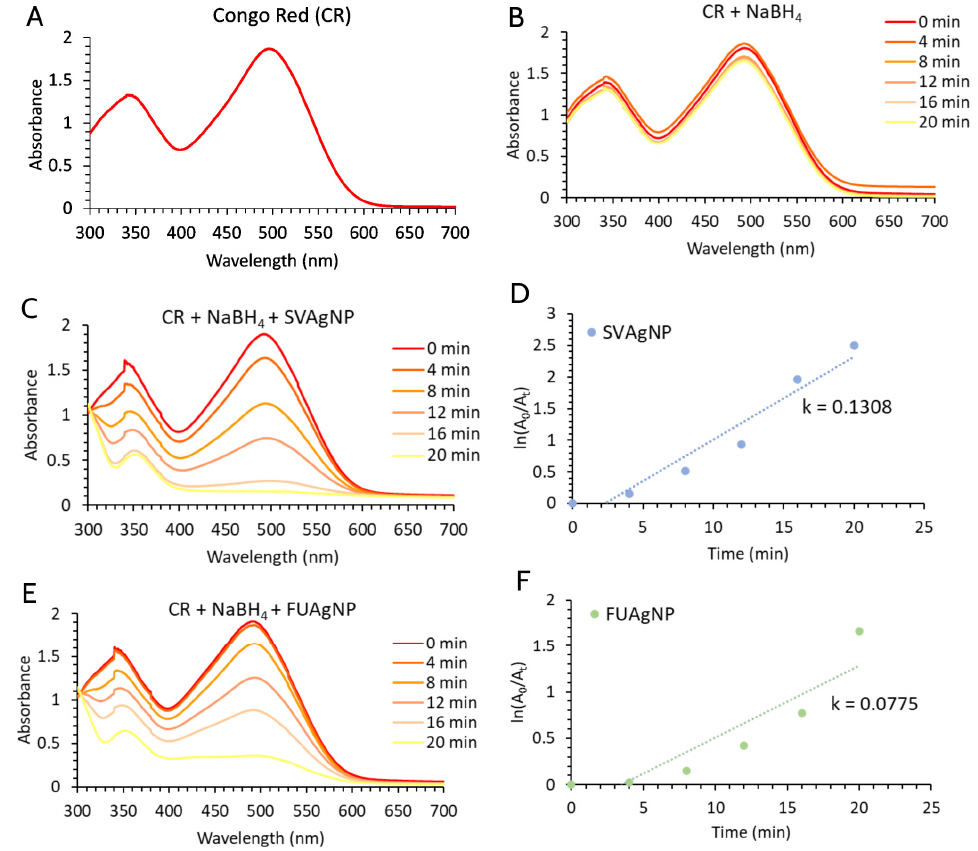
Figure 9. ( A ) UV–Vis spectra of the CR dye; ( B ) Degradation of CR in the presence of NaBH 4 ; The catalytic activity of SVAgNP ( C ) and FUAgNP ( E ) on CR degradation in the presence of NaBH 4 ; Degradation kinetics of CR in the presence of SVAgNP ( D ) and FUAgNP ( F ).